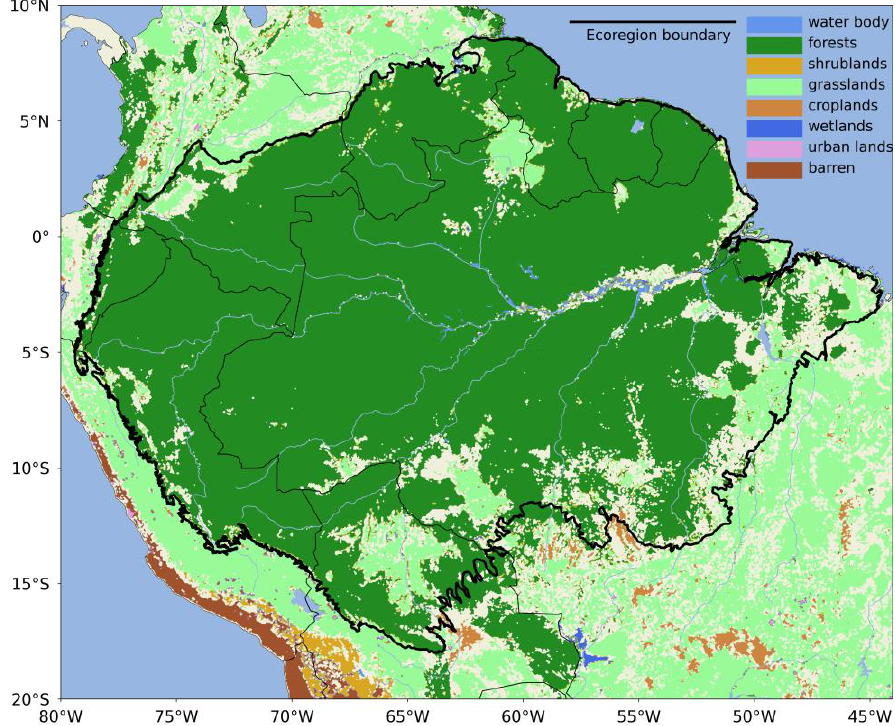
Figure 1. Amazon ecoregion based on the definition from the Terrestrial Ecoregions of the World.